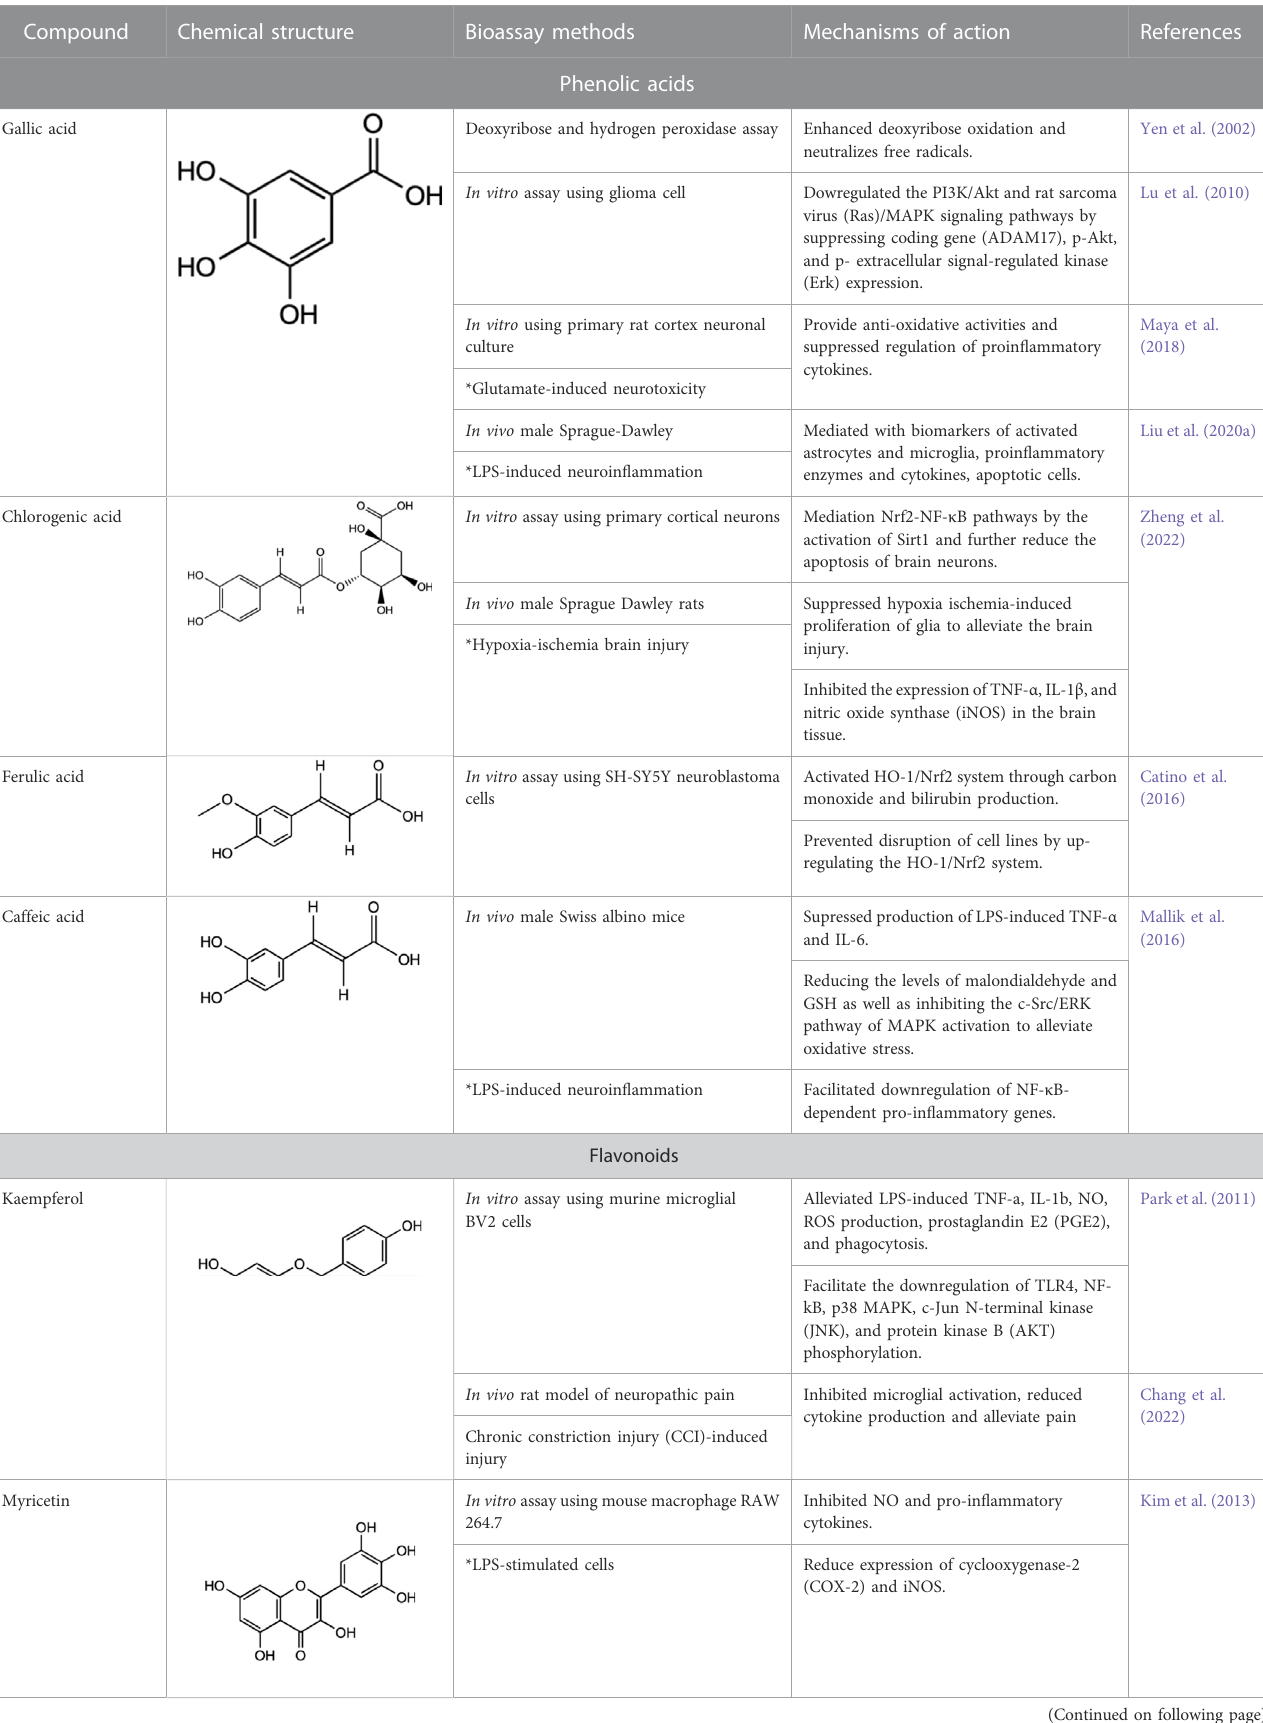
TABLE 1 Phytochemicals identi fi ed in M. oleifera with neuropharmacological effects and their mechanisms of